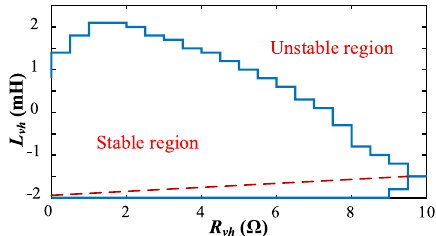
Fig. 13 Equivalent circuit model of parallel